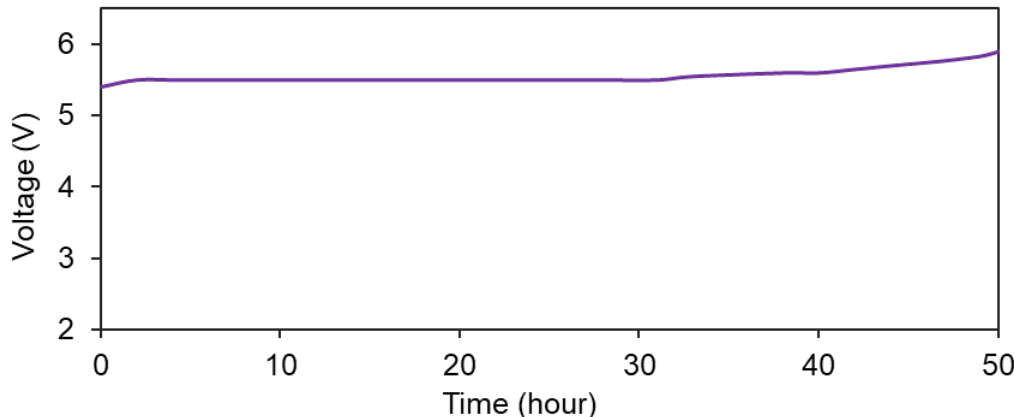
Figure 6. Voltage difference between the Ni 0.6 Co 0.4 -oxide anode and stainless steel cathode during the electrochemical degradation of 1g/L MB in 0.17 M Na 2 SO 4 at a current density of 20 mA/cm 2 .